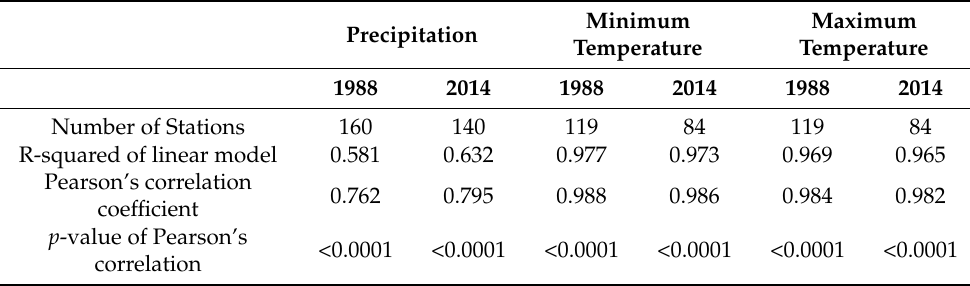
Table A1. Results of accuracy assessment of Daymet climatological data for A2A. Tests were per- formed using observed and predicted daily data for the beginning (1988) and end (2014) of the study period. The data used for validation are available for download [47]. Only the precipitation (prcp), minimum temperature (tmin), and maximum temperature (tmax) variables were available at the time that we performed this test. An ordinary-least squares linear model and a one-sided test of Pearson’s product moment correlation coefficient were used to assess the similarity between observed data from climatological stations and spatially corresponding predicted values from interpolated Daymet data.